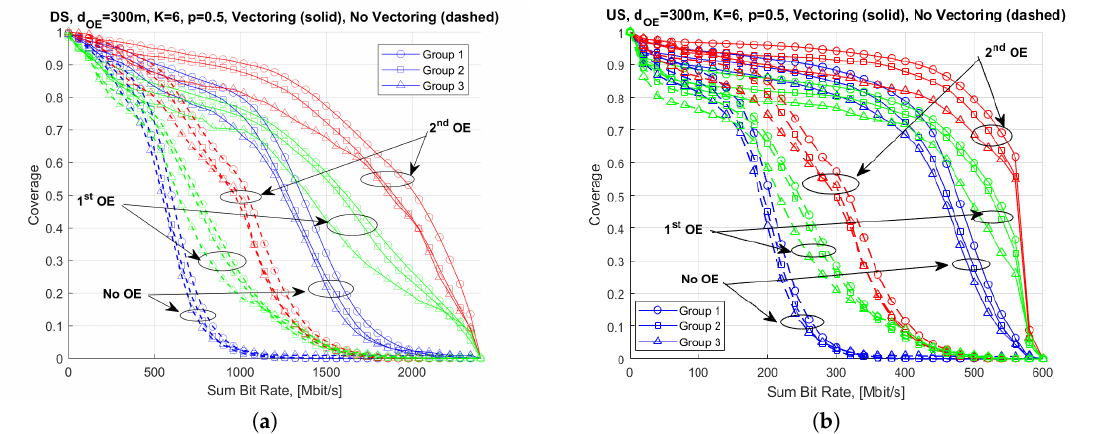
Figure 6. Sum bit rate coverage for the three groups, d OE = 300 m—number of pairs assigned to each radio node K = 6, user activity factor p = 0.5, vectoring and non vectoring: DS ( a ); US ( b ).